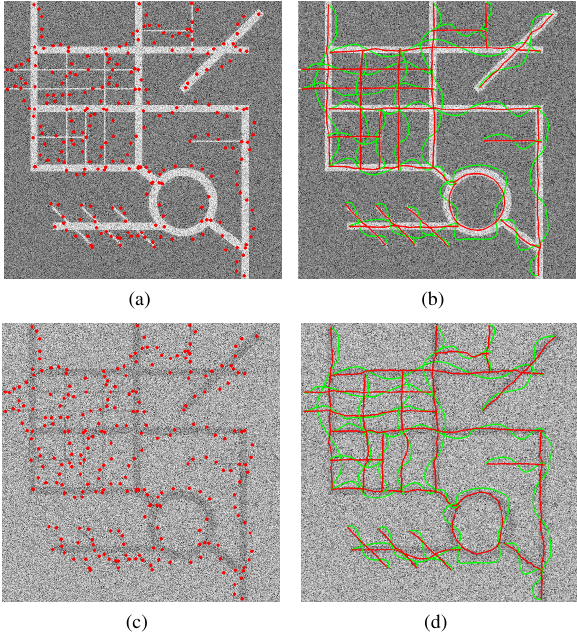
Figure 5: (a) Seed points manually selected on single look synthetic image, VV polarization. (b) Green contours represents the initial curves before the Snakes, and red, the final result for the VV polarization synthetic image. (c) Seed points man- ually selected on single look synthetic image, HH polarization. (d) Green contours represents the initial curves before the Snakes, and red, the final result for the HH polarization synthetic image. The evolution of the curve for the central of light or dark features depends exclusively on the weighting factor w . Negative line